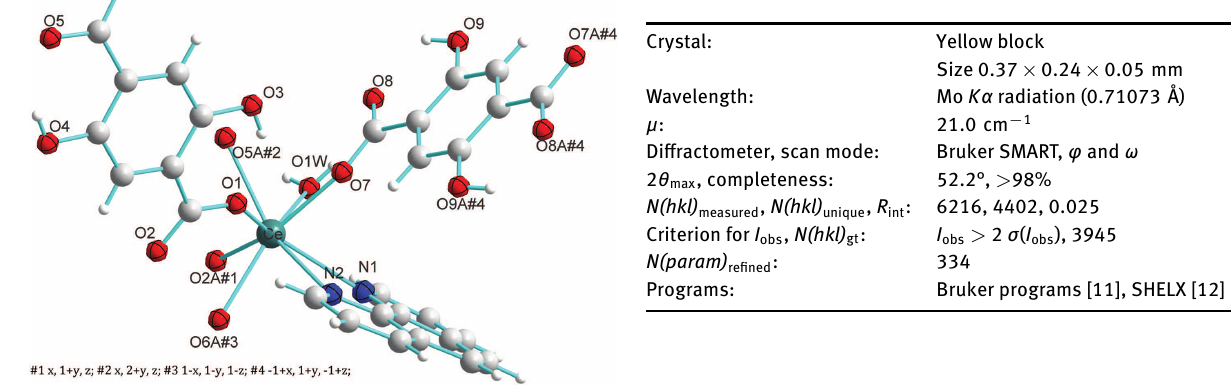
Table 1: Data collection and